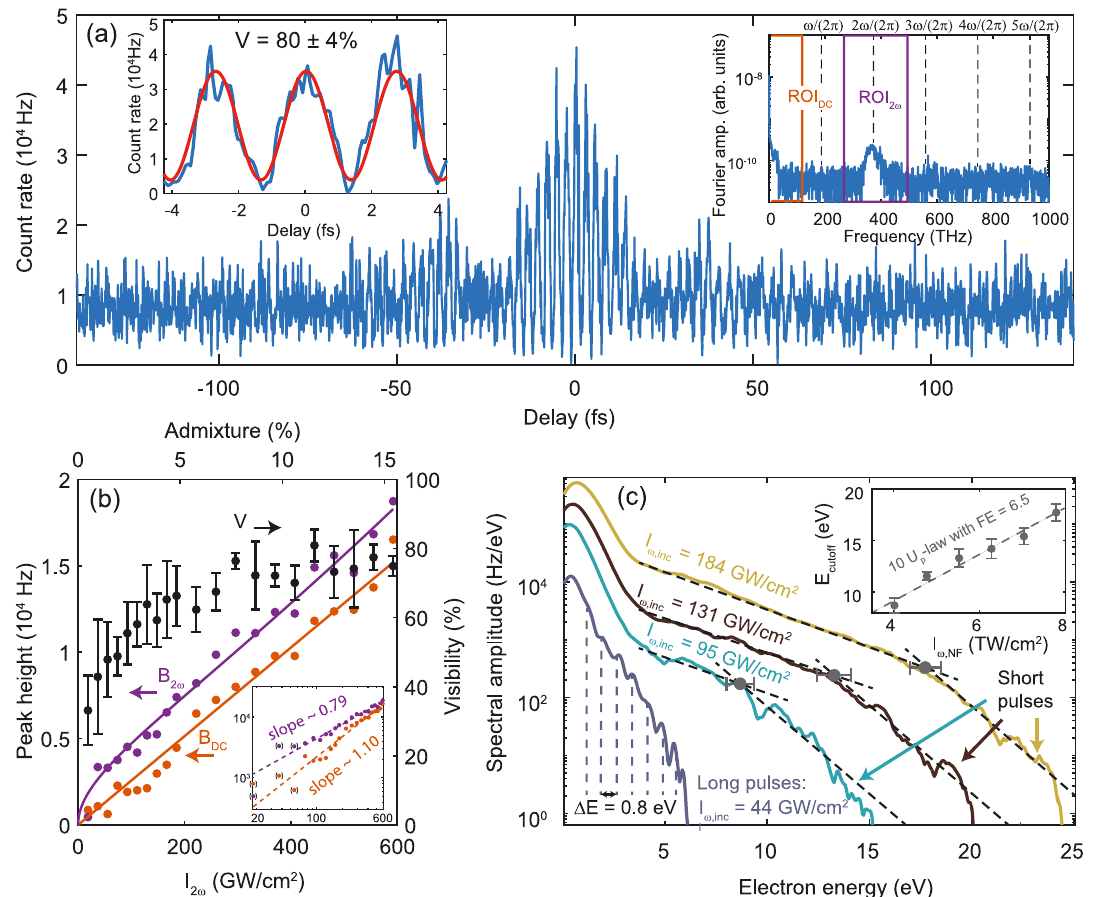
Figure 2: Coherent control and strong-field rescattering signatures. (a) Electron count rate as a function of the delay between fundamental and second harmonic field for a gold tip. Left inset shows the center of the temporal overlap with a sinusoidal fit (red line) used to determine = 440 GW/cm 2 . Right inset: the visibility at a fundamental nearfield intensity of I 𝜔 = 3 . 8 TW/cm 2 and second harmonic intensity of I 2 𝜔 Frequency spectrum obtained via Fourier transform from the 𝜔 − 2 𝜔 delay trace shown. Broadband components centered around the DC and and ROI . (b) Envelope peak heights B and B of individually 2 𝜔 /(2 𝜋 ) frequencies are labeled as regions of interest ROI DC 2 𝜔 DC 2 𝜔 and ROI together with the measured visibility as a function of the second harmonic intensity. Inset shows back-transformed regions ROI DC 2 𝜔 B and B in a double-logarithmic scale with corresponding slopes. The three lowest second harmonic intensities (indicated by brackets) DC 2 𝜔 are excluded from the linear fits. (c) Electron energy spectra using few-cycle fundamental pulses or multi-cycle driving pulses as previously used in [32–34]. Above-threshold photoionization peaks spaced with Δ E = 0 . 8 eV are visible for long driving pulses. Rescattering